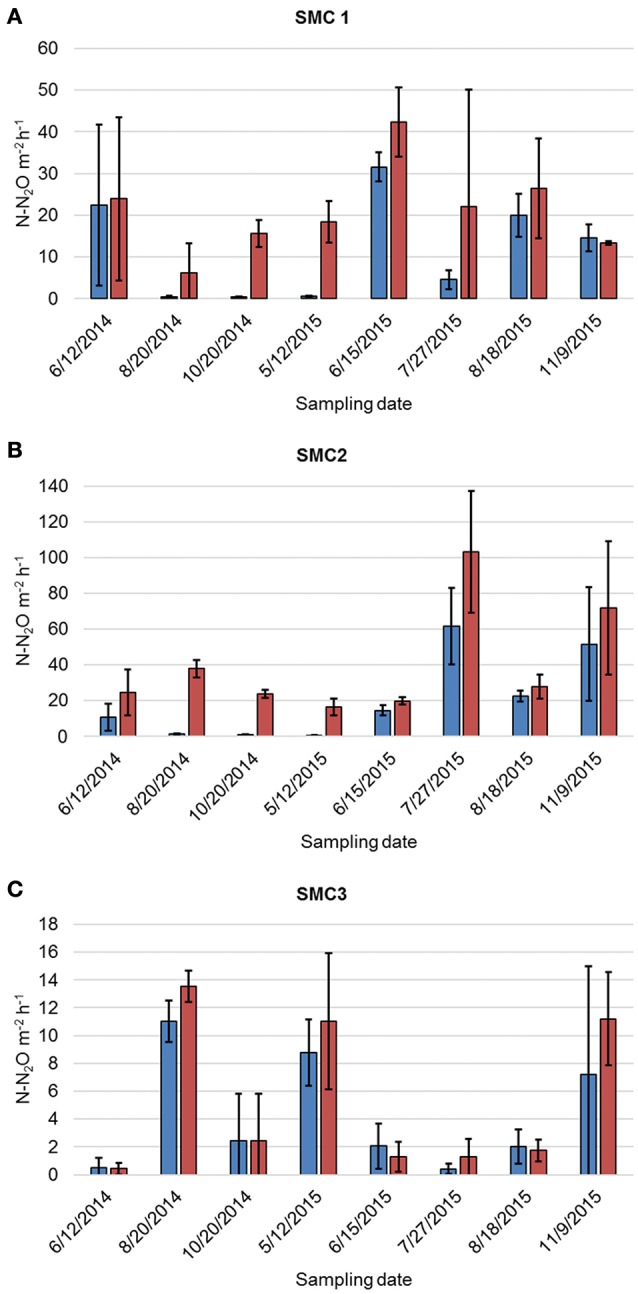
Mean denitrification rates of triplicate samples collected from channel positions at (A) SMC1, (B) SMC2, and (C) SMC3. Error bars reflect standard deviation. Blue bars represent DNU and red bars represent DNA.